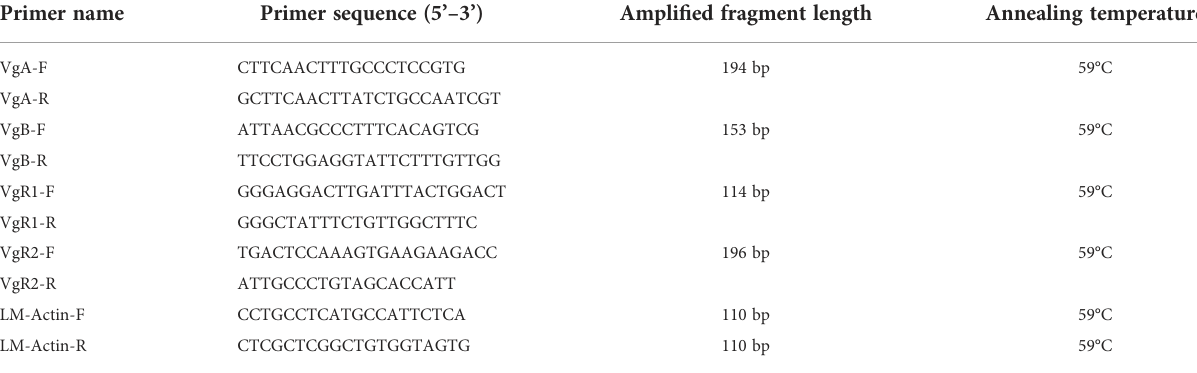
TABLE 1 RT-qPCR